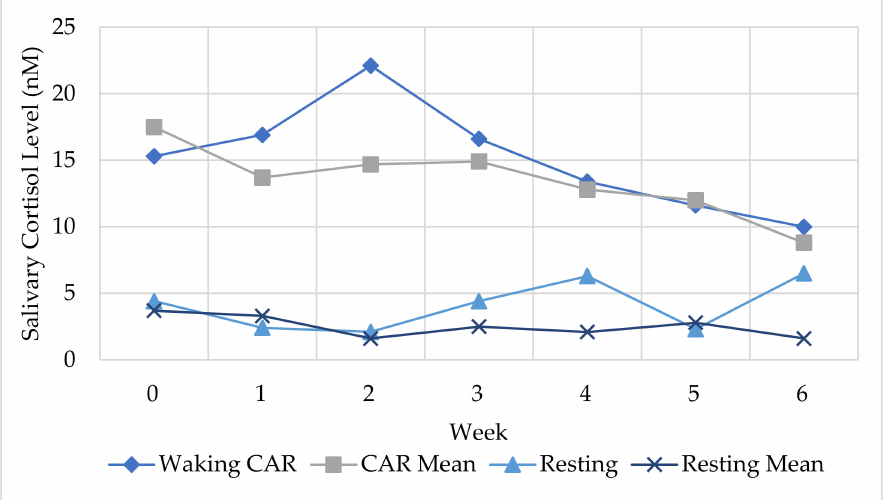
Figure 8. Change in waking (CAR) and resting salivary cortisol levels from week 0 to week 6 for Sarah. Table 7. Summary of self-report measures for Sarah pre-and post-program and 3-month follow-up. Measures Week